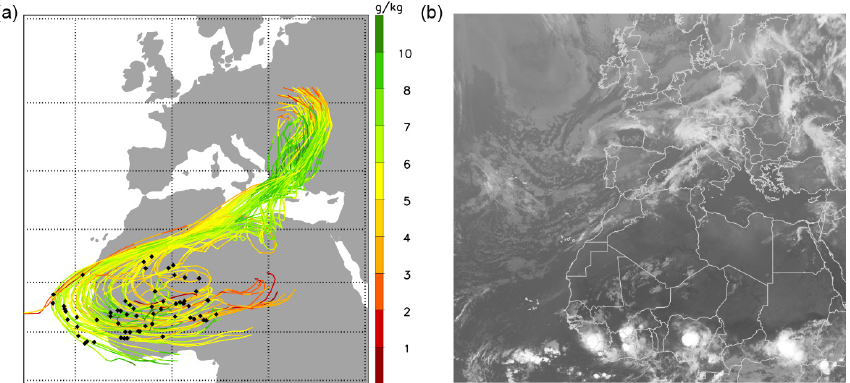
Figure 7. Left panel: 168h backward trajectories from the region of the precipitation event, started at 12:00UTC on 16 May 2010, with the condition of at least 30 ◦ northward movement during the calculation time (only every second trajectory is shown). The black dots mark the position of the air parcel at 00:00UTC on 10 May 2010. Right panel: EUMETSAT infrared image at 00:00UTC on 10 May 2010. The white colours in the tropics indicate convective cloud systems.